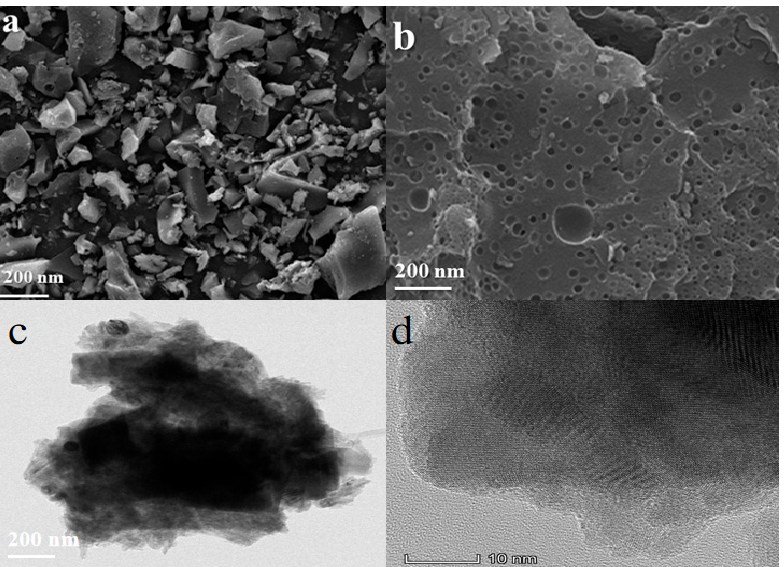
Figure 2. SEM images of ( a ) CLR and ( b ) CLR-PC materials, and TEM images of CLR-PC ( c , d ).